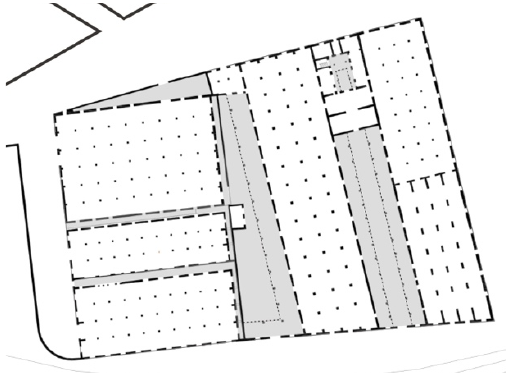
Figure 7. Basilical plant example. (Aladro-Prieto, 2012).